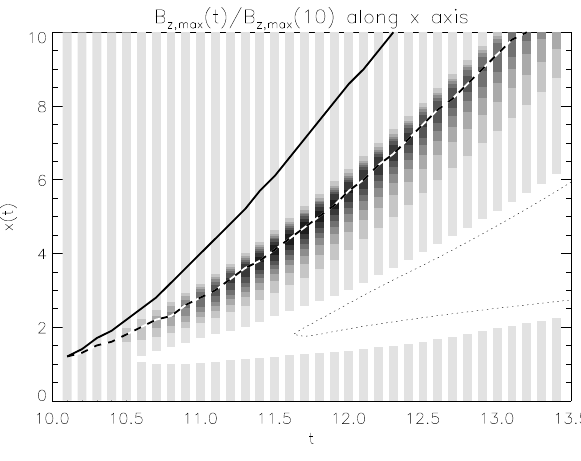
Fig. 8. Height-time plot tracing the position of the normalized maximum of B z , which moves slightly ahead of the actual CME. Each vertical strip can be thought of as a cut along the x-axis of Fig. 7 with identical color scale (including the dotted inversion line). The thick dashed line connects the respective maxima, thus forming an t 7→ x(t) position curve for the magnetic peak leading the CME. The solid line shows the corresponding x(t) plot for the faster CME ( u cme = 2 rather than 0). The corresponding contour stripes for this second CME are not